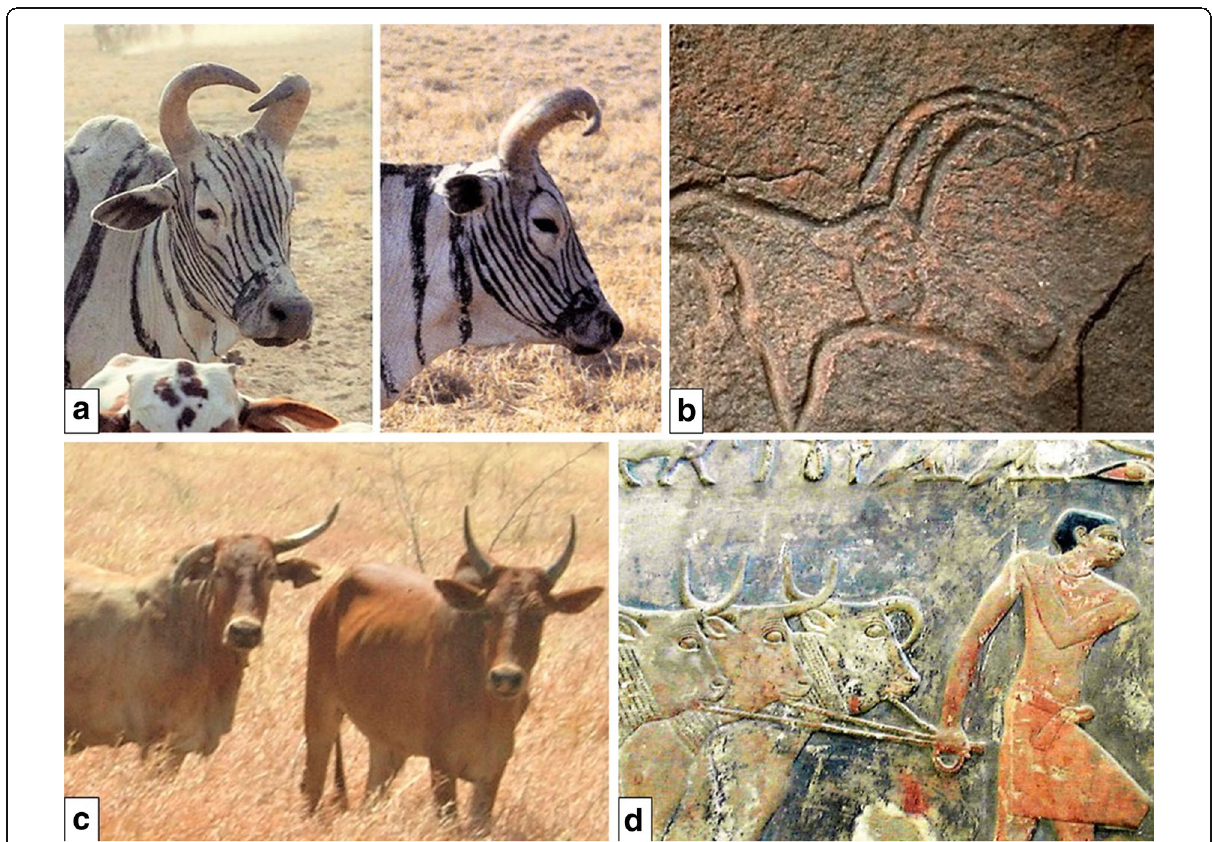
Fig. 6 Horn deformation: a A favourite-ox showing “ forward pointing ” horns, Lotikipi Plain. b A depiction of an ox with a similar horn deformation from the rock art of Wadi Mathendous area, Libya, approx 7000 to 6000 BC (David Coulson, Trust for African Rock Art). c A favourite-ox showing horn asymmetry: one horn bent downwards, (Kidepo, Uganda). d Detail of a similar horn deformation visible on the East Wall reliefs of the tomb of Ptahhotep in Saqqara, Egypt, approx 2500 BC (Thierry Benderitter,